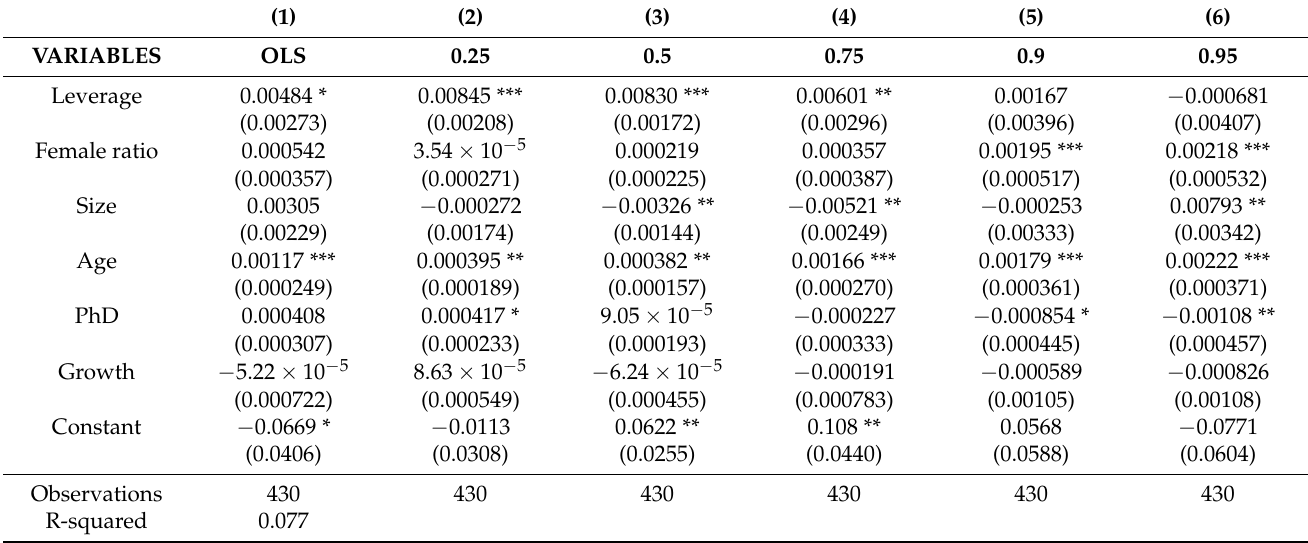
Table 9. The Quantile impact of gender diversity on ROA.